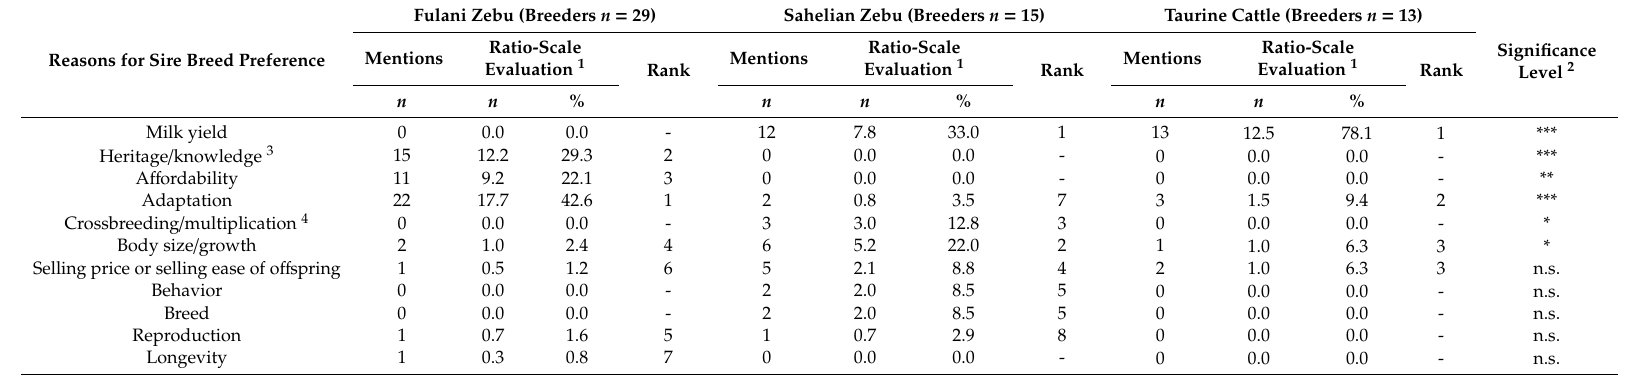
Table 2. Preferences for local and imported sire breeds used by cattle breeders in